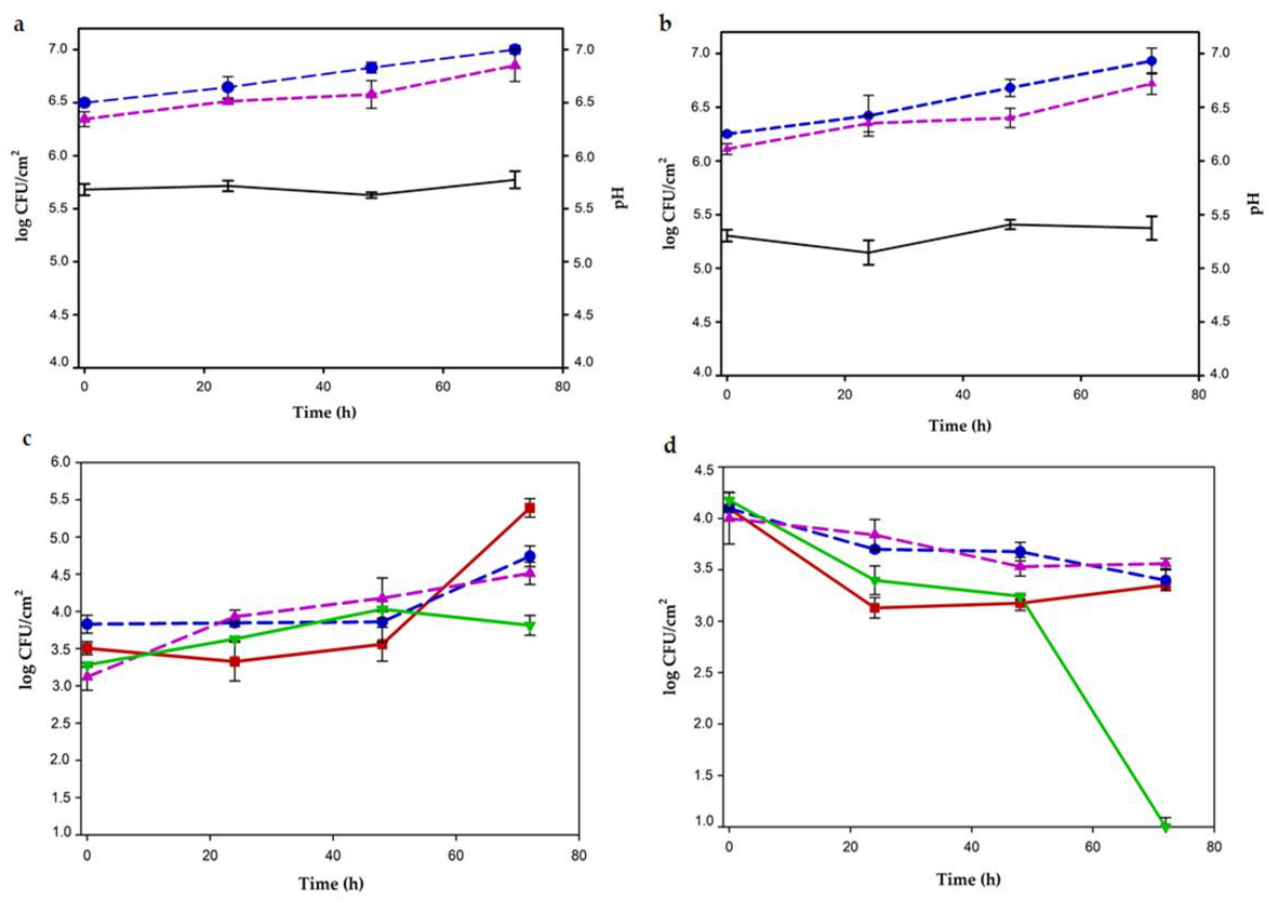
Figure 3. LAB and EHEC growth kinetics (log CFU/cm 2 ) in individual culture and in co-culture on meat discs at 8 ◦ C. ( a ) pH (black line) and individual growth of L. plantarum CRL681 (blue dotted line) and E. mundtii CRL 35 (magenta dotted line) without lactic acid (LA). ( b ) pH (black line) and individual growth of CRL681 (blue dotted line) and CRL35 (magenta dotted line) with the addition of 0.6% LA. ( c ) EHEC growth in individual culture (red line) and influenced by the presence of LAB ( L. plantarum + EHEC, blue dotted line; E. mundtii + EHEC, magenta dotted line and L. plantarum CRL681 + E. mundtii CRL35 + EHEC, green line) without the addition of LA. ( d ) Viability of EHEC in individual culture (red line) and in co-culture in the presence of LAB ( L. plantarum + EHEC, blue dotted line; E. mundtii + EHEC, magenta dotted line and L. plantarum CRL681 + E. mundtii CRL35 + EHEC, green line) with the addition of 0.6%